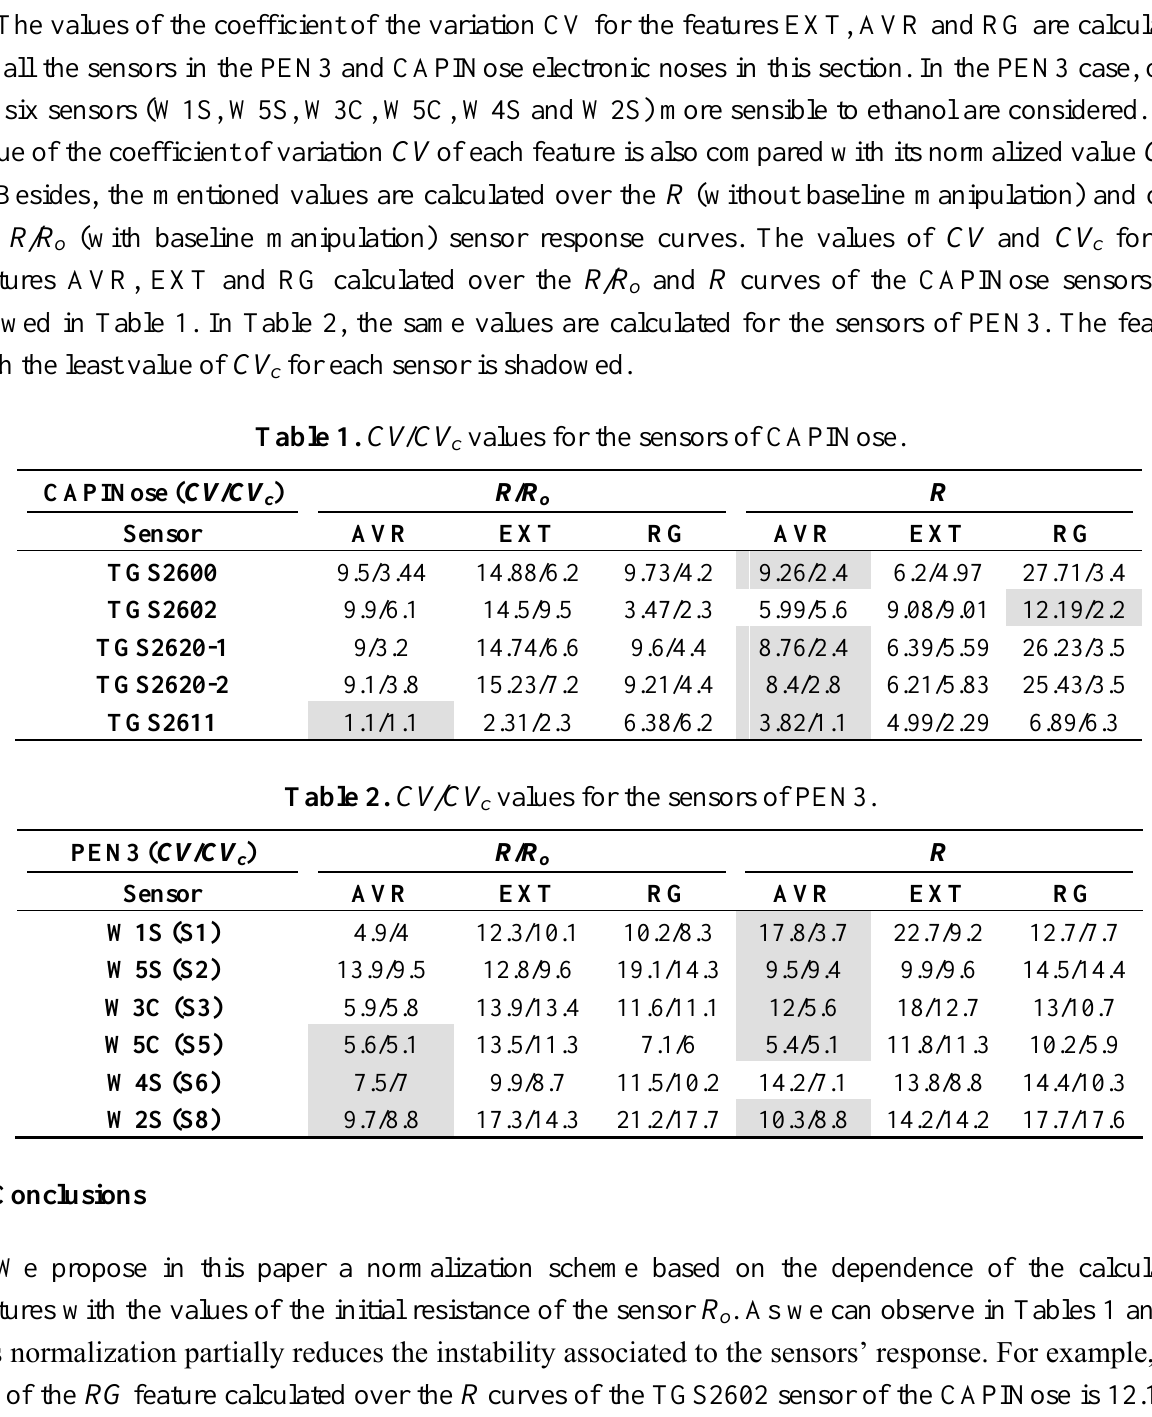
Table 1. CV / CV values for the sensors of CAPINose. c